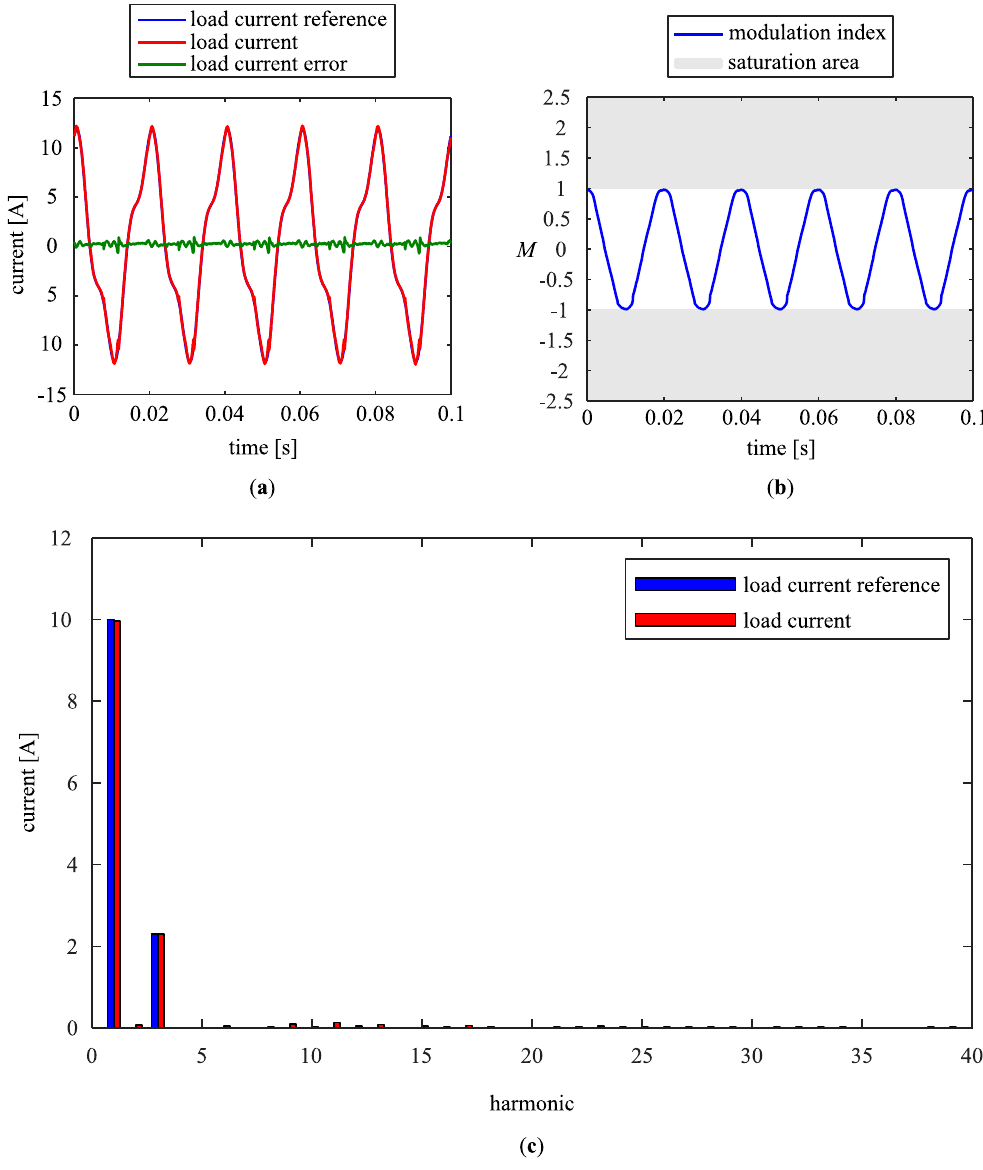
Figure 8. Power converter operating at the saturation limit V S max ; ( a ) Load current reference i* (containing fundamental harmonic with amplitude of 10 A and the third harmonic with amplitude of 2.3 A), load current i and load current error ε ; ( b ) modulation index M; ( c ) frequency spectra of load current reference i* and load current i .